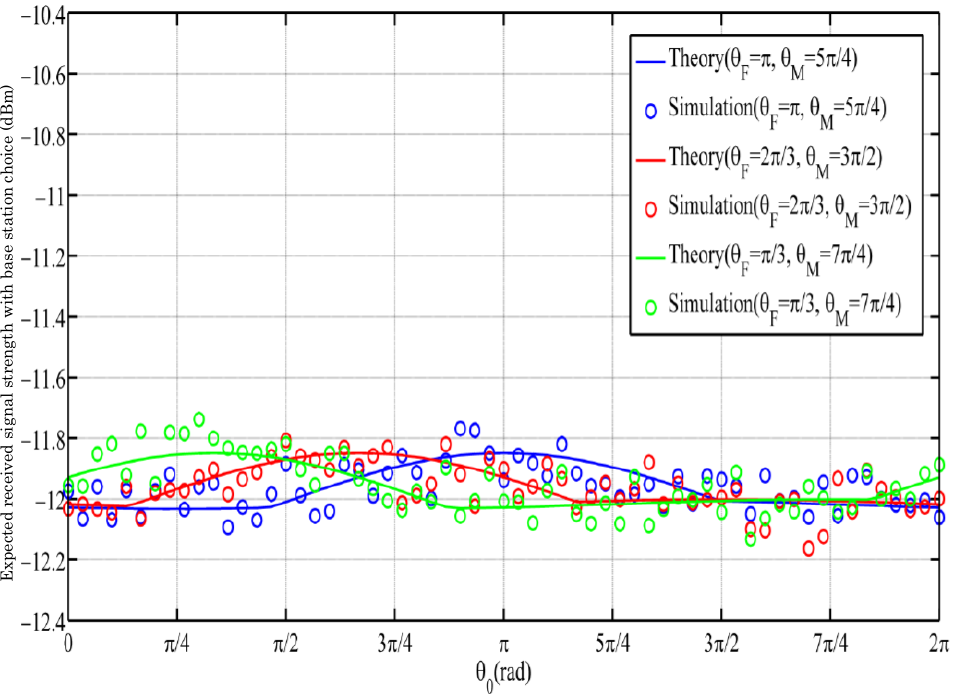
Figure 12. When r = 4.5 m/s, expected RSS with base station choice.